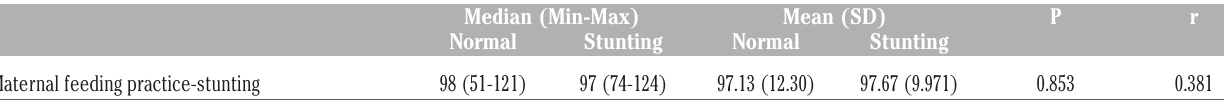
Table 3. Description of correlation between maternal feeding practice and stunting incidence in children in Depok, April 2019 (n=262).